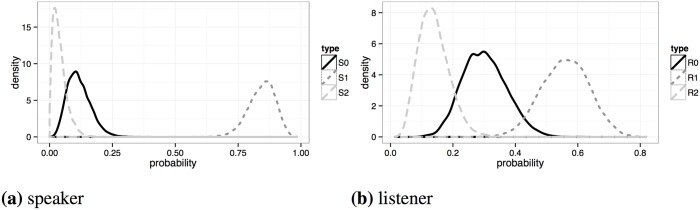
Marginal posterior for type priors Pτ (τi).